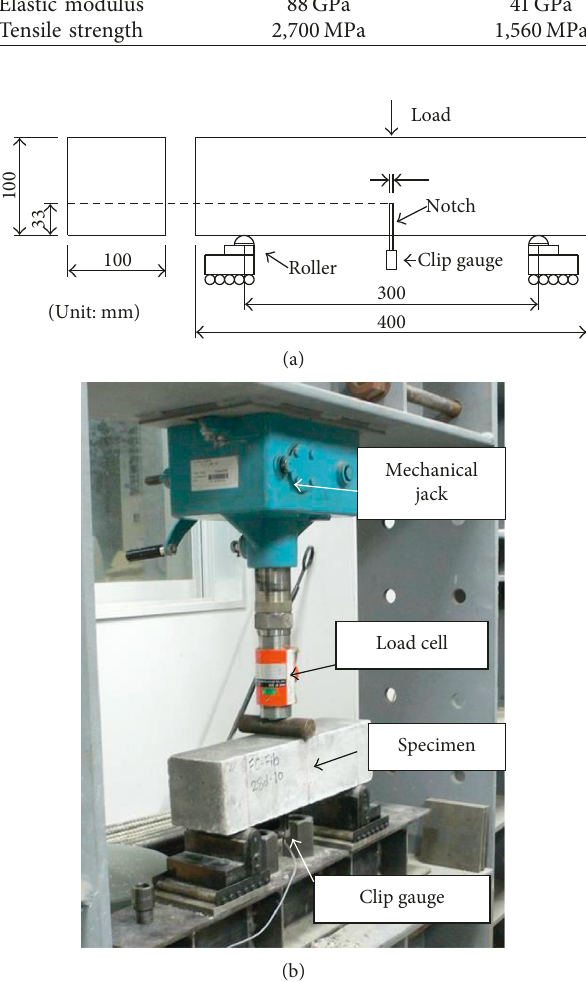
Figure 2: Flexural test: (a) specimen size; (b) test view.